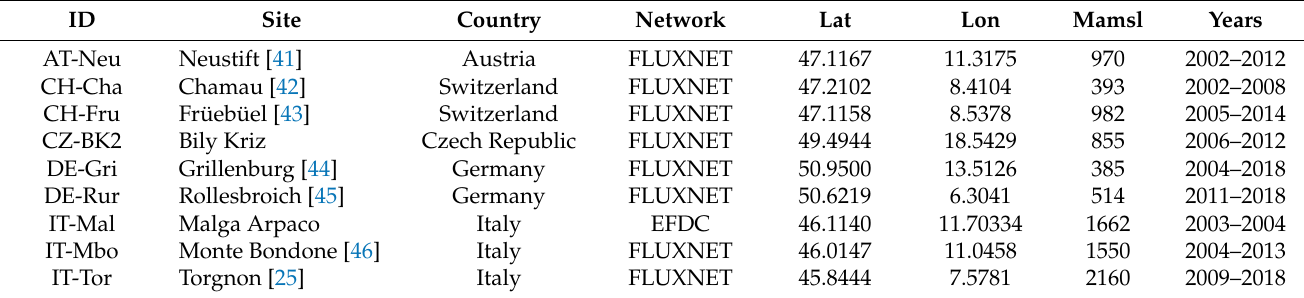
Table 1. List of grassland sites used to obtain daily GPP data. Mamsl represents meters above mean sea level (m), while EFDC represents the European Fluxes Database